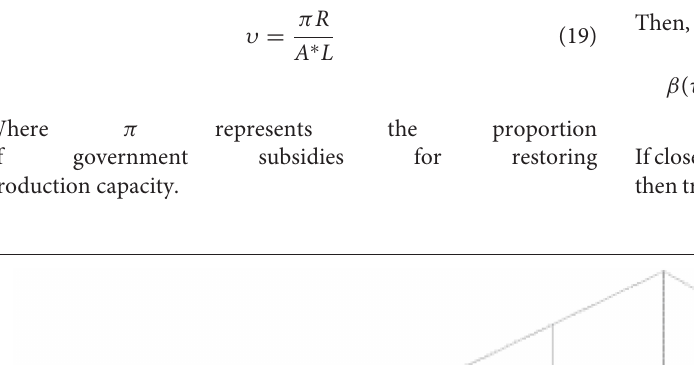
Frontiers in Public Health |